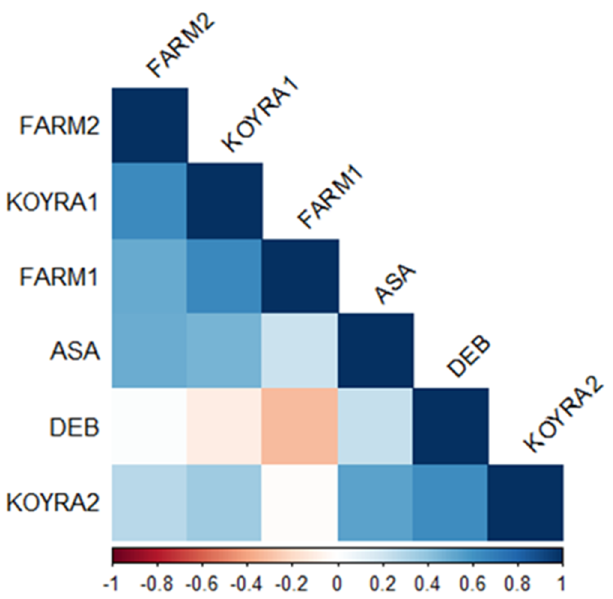
Figure 8. Heatmap of linear Pearson’s correlation coefficients between grain yield tested in diverse